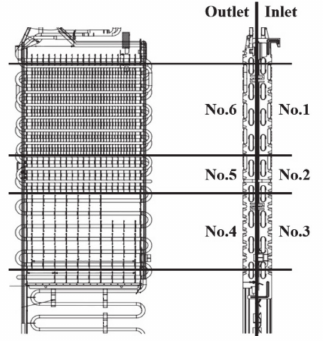
Figure 9. Schematic of the evaporator